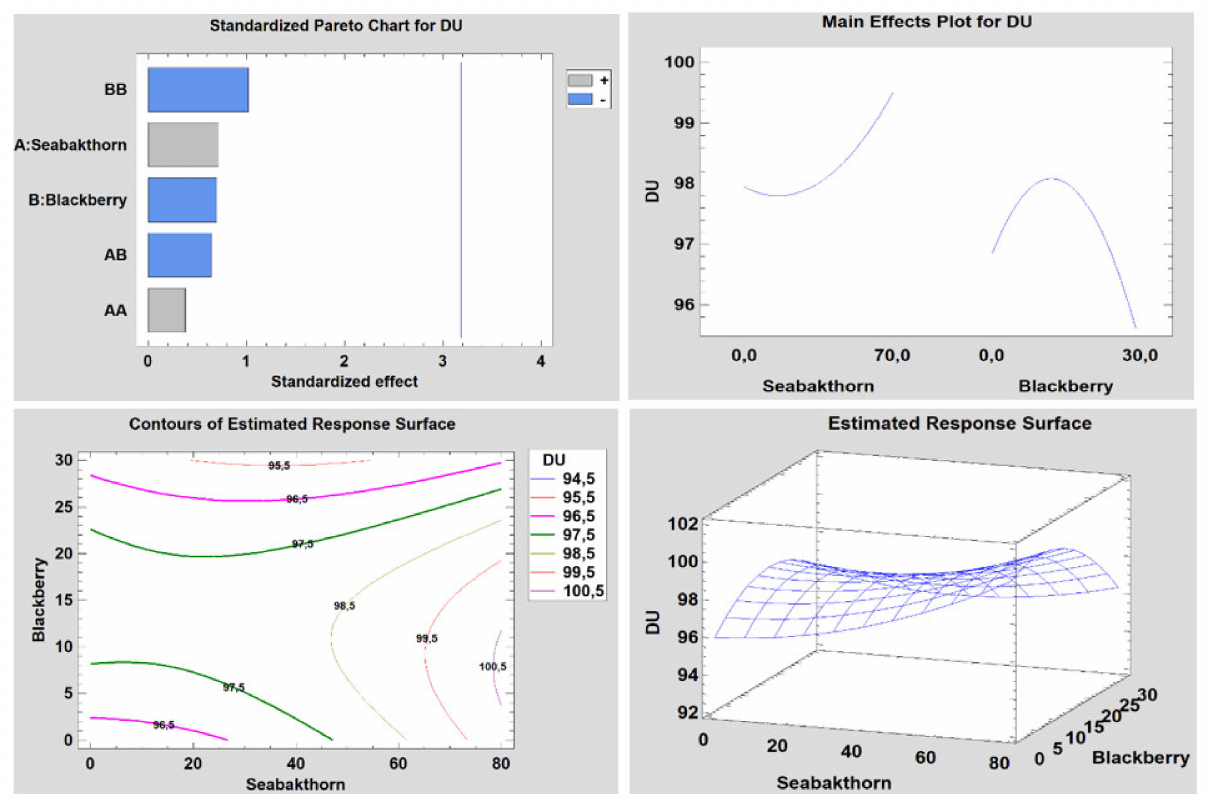
Figure 5. Graphical representation of the dependence of the mechanical durability of the pellets according to the percentage of the constituents of the raw material (seabuckthorn biomass + black- berry +